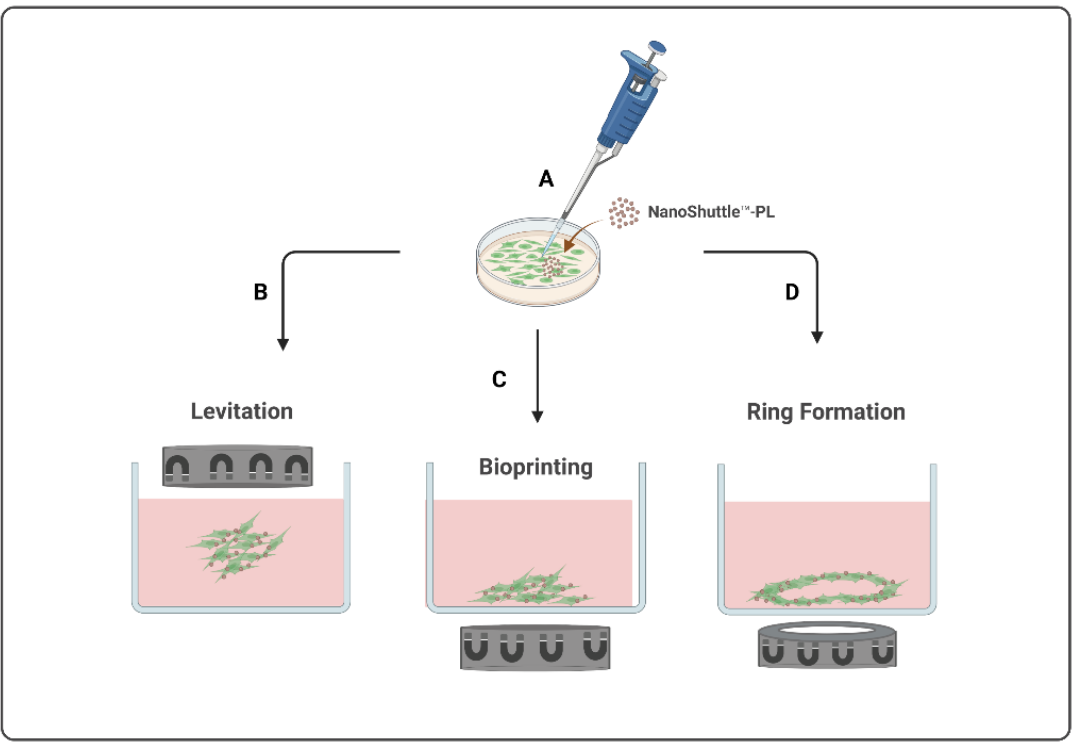
Figure 1. Schematic illustration of magnetic-based 3D (m3D) systems to develop 3D structures. This method starts with the magnetization of the cells ( A ) to generate 3D structures by levitation ( B ), bioprinting ( C ), or by ring formation ( D ).